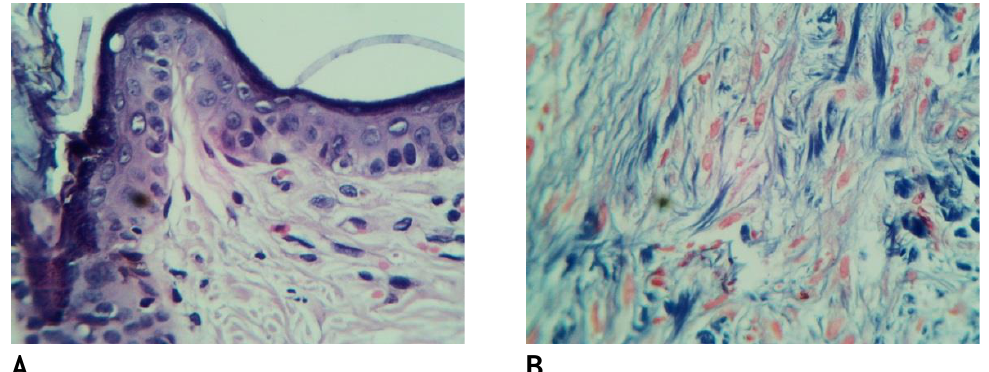
Figure 7: View of control group at day 14 showed, A: keratin layer, epidermis, granulation tissue, H&E,X10. B: granulation tissue and blue area: remodeling of collagen fiber. MT,X40. Fourteen days duration (Experimental group):Fig .